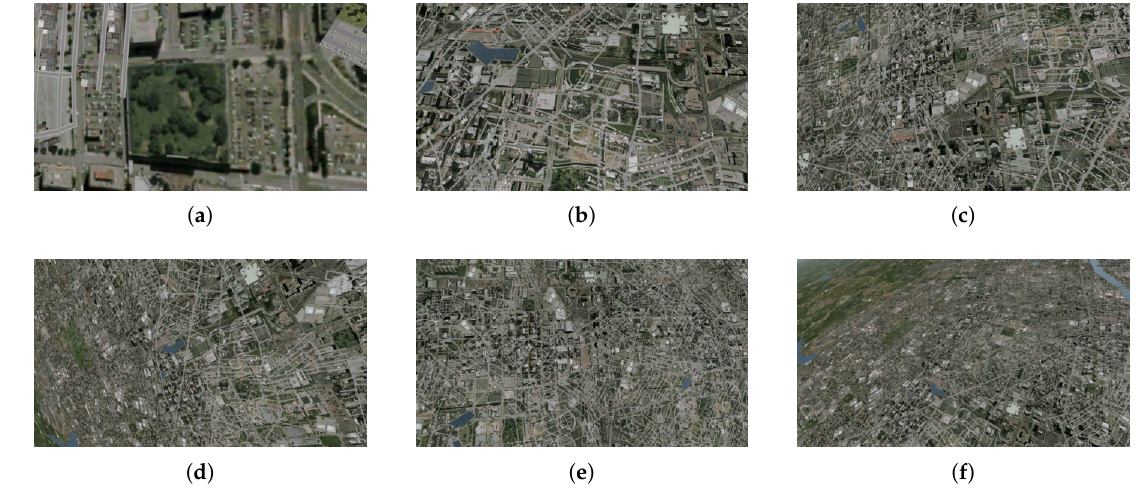
Figure 11. Selected frames from test videos in group 3: ( a ) 2000 ft, ( b ) 4000 ft, ( c ) 6000 ft, ( d ) 8000 ft, ( e ) 10,000 ft, ( f ) 12,000